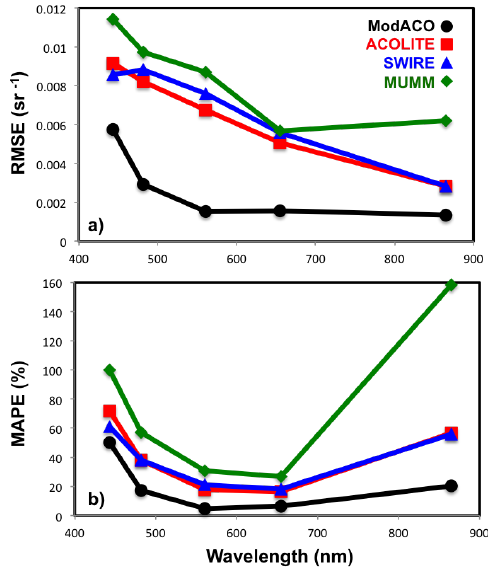
‘ Figure 3. The accuracy in terms of RMSE and MAPE of different atmospheric correction schemes at the NIR and visible